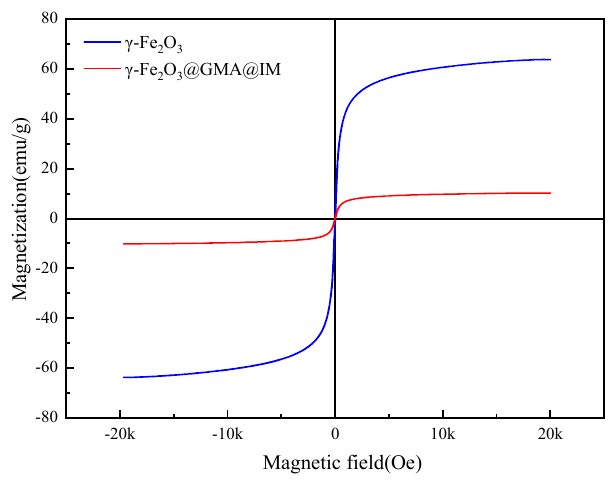
Figure 5. The hysteresis loop of γ -Fe 2 O 3 @GMA@IM.